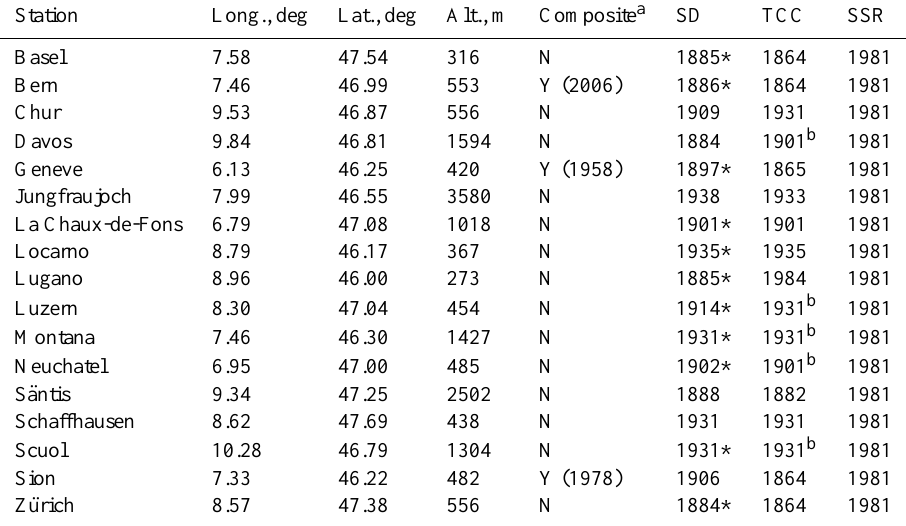
Table 1. Details of the 17 stations over Switzerland used in this study, including the starting year for sunshine duration (SD), total cloud cover (TCC), and surface solar radiation (SSR) measurements at each station.